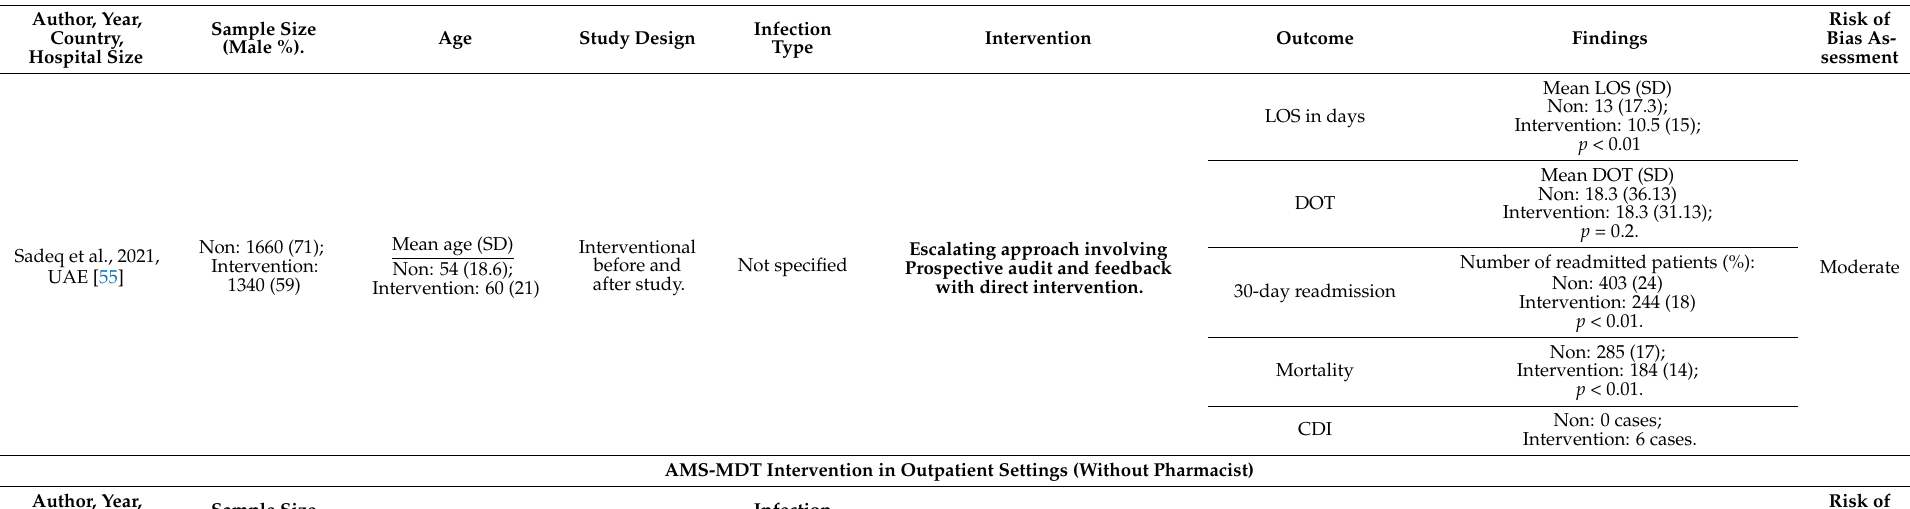
AMS-MDT Intervention in Inpatient Settings (With